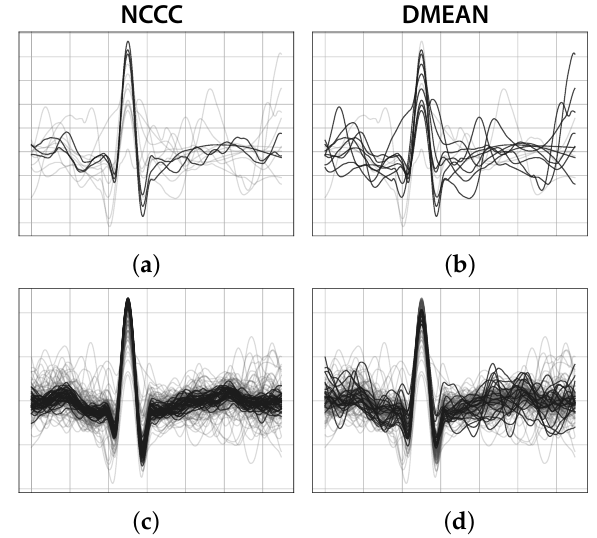
Figure 5. Comparison between DMEAN and NCCC, the proposed approach for outlier detection and removal, with two example template sets (first row: first template set with NCCC ( a ) and DMEAN ( b ); second row: second template set with NCCC ( c ) and DMEAN ( d ); dark lines: Selected heartbeats; light grey lines: Templates rejected as outliers).